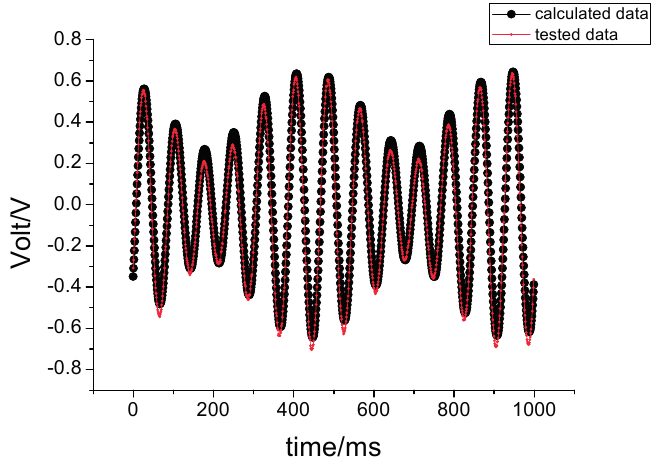
Figure 13. The experimental results under input circular vibration.